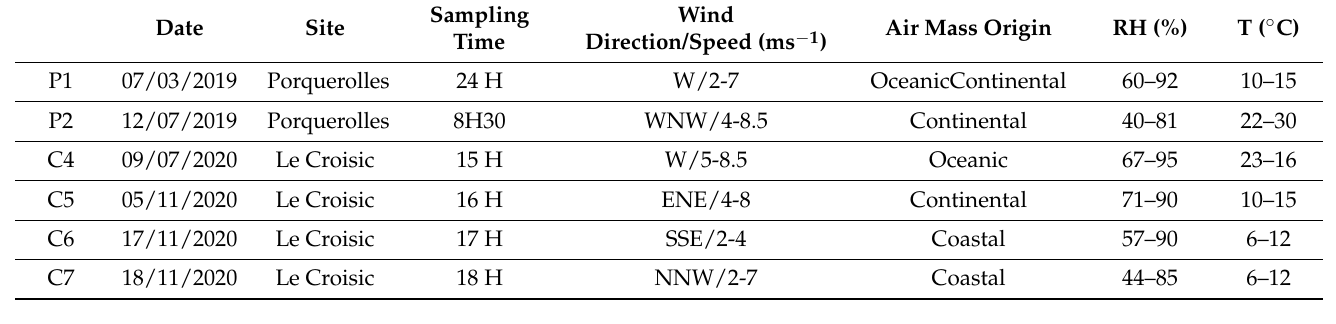
Table 1 . List of samples collected using the impactor between March 2019 and January 2021 in the two experimental sites.